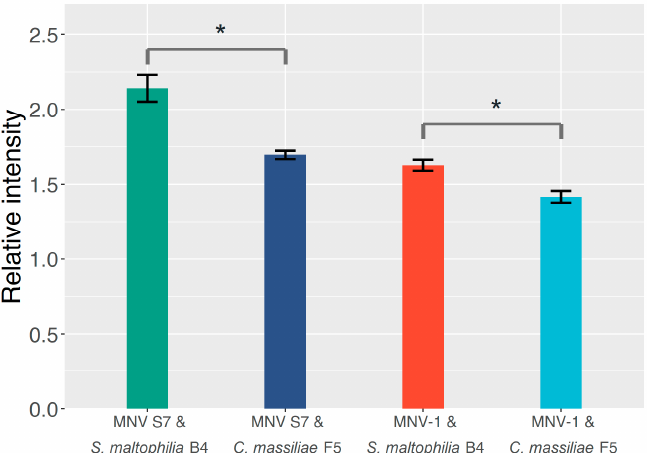
Figure 2. The ELISA results for the four bacterium–murine norovirus (MNV) combinations. The extent of binding is measured according to the relative adsorption intensity, calculated by dividing the absorption values of the test group by those of the control group. The heights of the main bars and error bars represent the average values and standard deviations from three independent parallel experiments. *: p < 0.05.